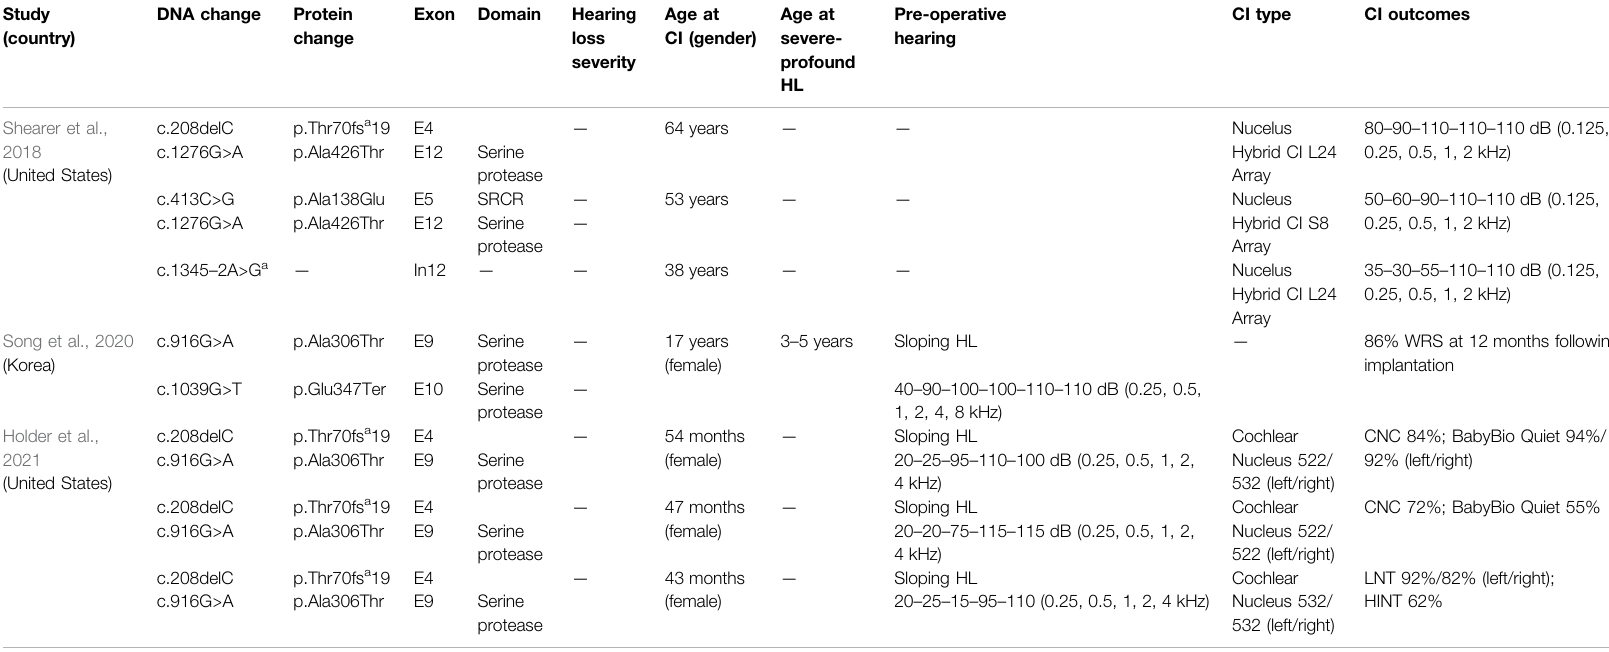
TABLE 2 | ( Continued ) Overview of clinical characteristics and genotypes of patients with TMPRSS3 variants who have received cochlear